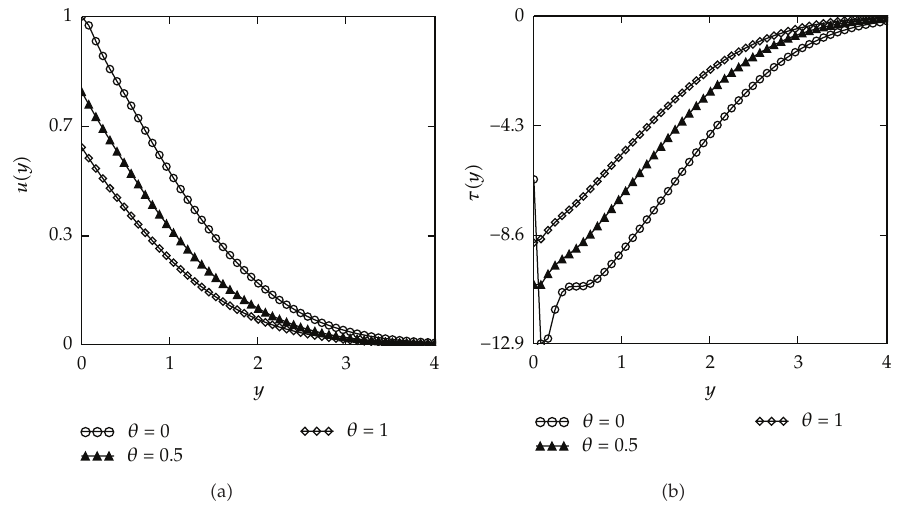
Figure 11: Profiles of the velocity field u (cid:4) y,t (cid:5) and the shear stress τ (cid:4) y,t (cid:5) for fractional Maxwell fluid given by (cid:4) 4.7 (cid:5) and (cid:4) 4.15 (cid:5) , for U (cid:9) 1, y (cid:9) 1, ν (cid:9) 0 . 379, μ (cid:9) 33, λ (cid:9) 1 . 5, α (cid:9) 0 . 2, t (cid:9) 5s, and di ff erent values of θ